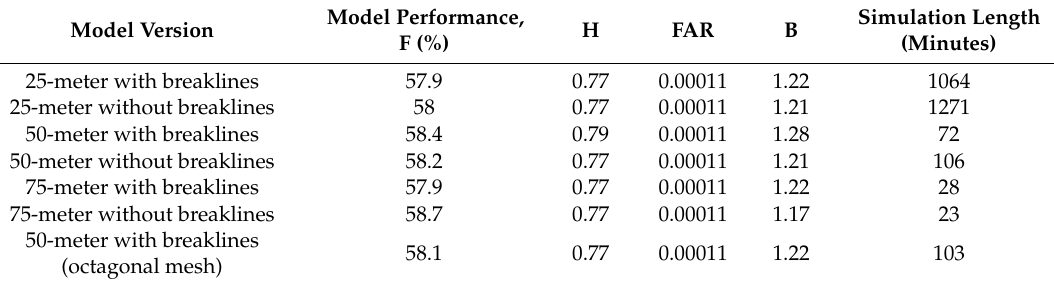
Table 3. Model performance and simulation length at di ff erent grid